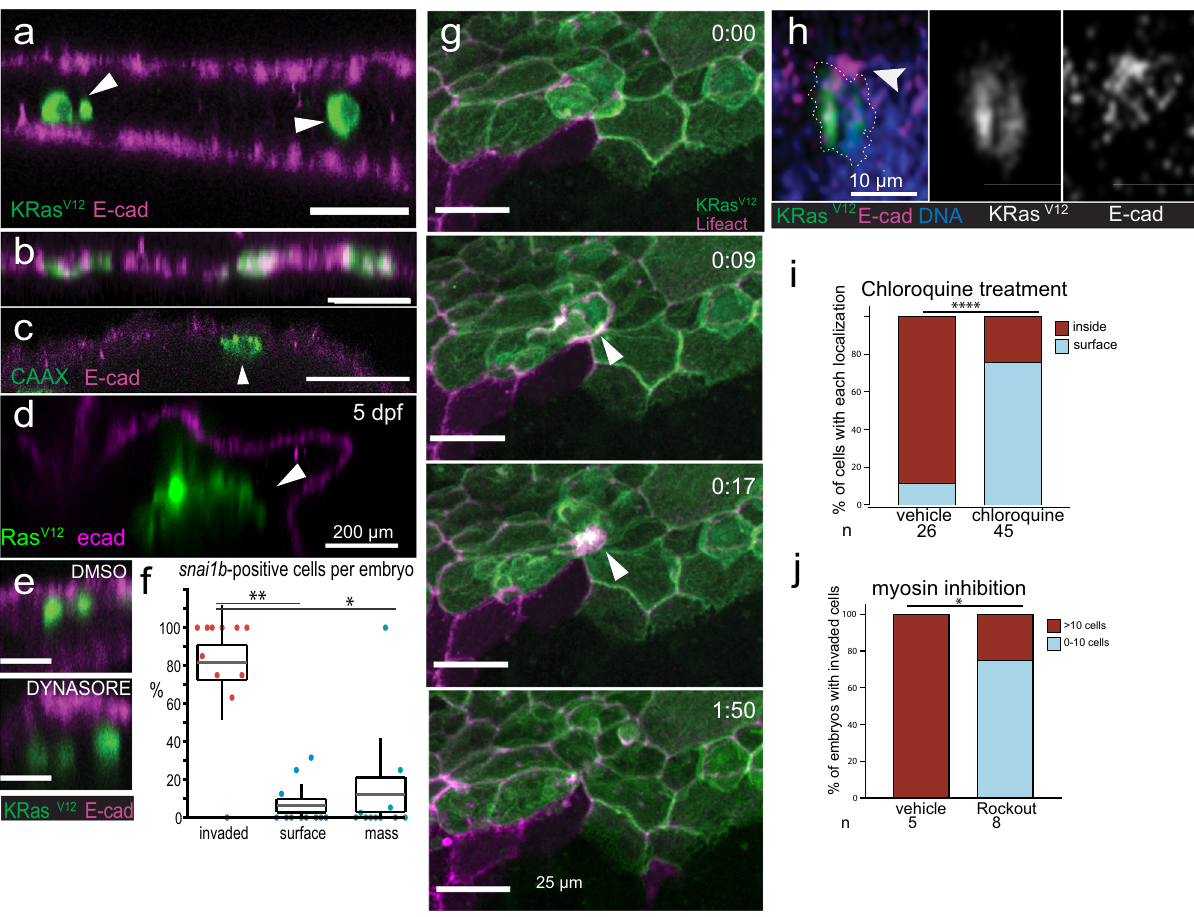
Fig. 4 KRas V12 cells invade by BCE and shed apical epithelial determinants. XZ sections of 48 hpf EGFP-dt-KRas V12 embryos with E-cadherin – internalized cells ( a , arrowheads) and EGFP-CAAX embryos, where cells remaining at epidermis and are E-cadherin + but the few that internalize are E-cadherin – ( b , c , arrowhead). Those in an internal cell mass (T2A-KRas V12 , arrowhead) at 5 dpf also lacks E-cadherin ( d ). e XZ sections of DMSO or 100 μ M Dynasore-treated T2A-KRas V12 /p53 MO-injected embryos showing internalized cells lack E-cadherin (arrowheads). f Percentage of invaded, surface, or mass-associated snai1b + cells in 14 embryos, * P < 0.05, ** P < 0.01 by a Friedman test and Wilcoxon signed-rank test with the Holm-Sidak adjustment for pairwise comparisons, n = 11 embryos. Data are represented as boxplots where the middle (grey) line is the mean, the hinges indicate ±SEM, and the whiskers indicate ±SD. All data points are shown. g Stills from Supplementary Movie 16 showing BCE of a EGFP-dt-KRas V12 cell in a periderm:Lifeact-mCherry line (arrowheads pointing to ring contracting), clipping off the apex (green). h XZ-section of a basally extruding EGFP-T2A- KRas V12 cell (dashed) with E-cadherin constricted apically (arrowhead). Analysis of invasion in vehicle versus chloroquine-treated ( i ) or Rockout-treated ( j ) embryos at 48 hpf, *** P < 0.001, * P < 0.05 by a Fisher Exact Test. Source data are provided as a Source Data fi